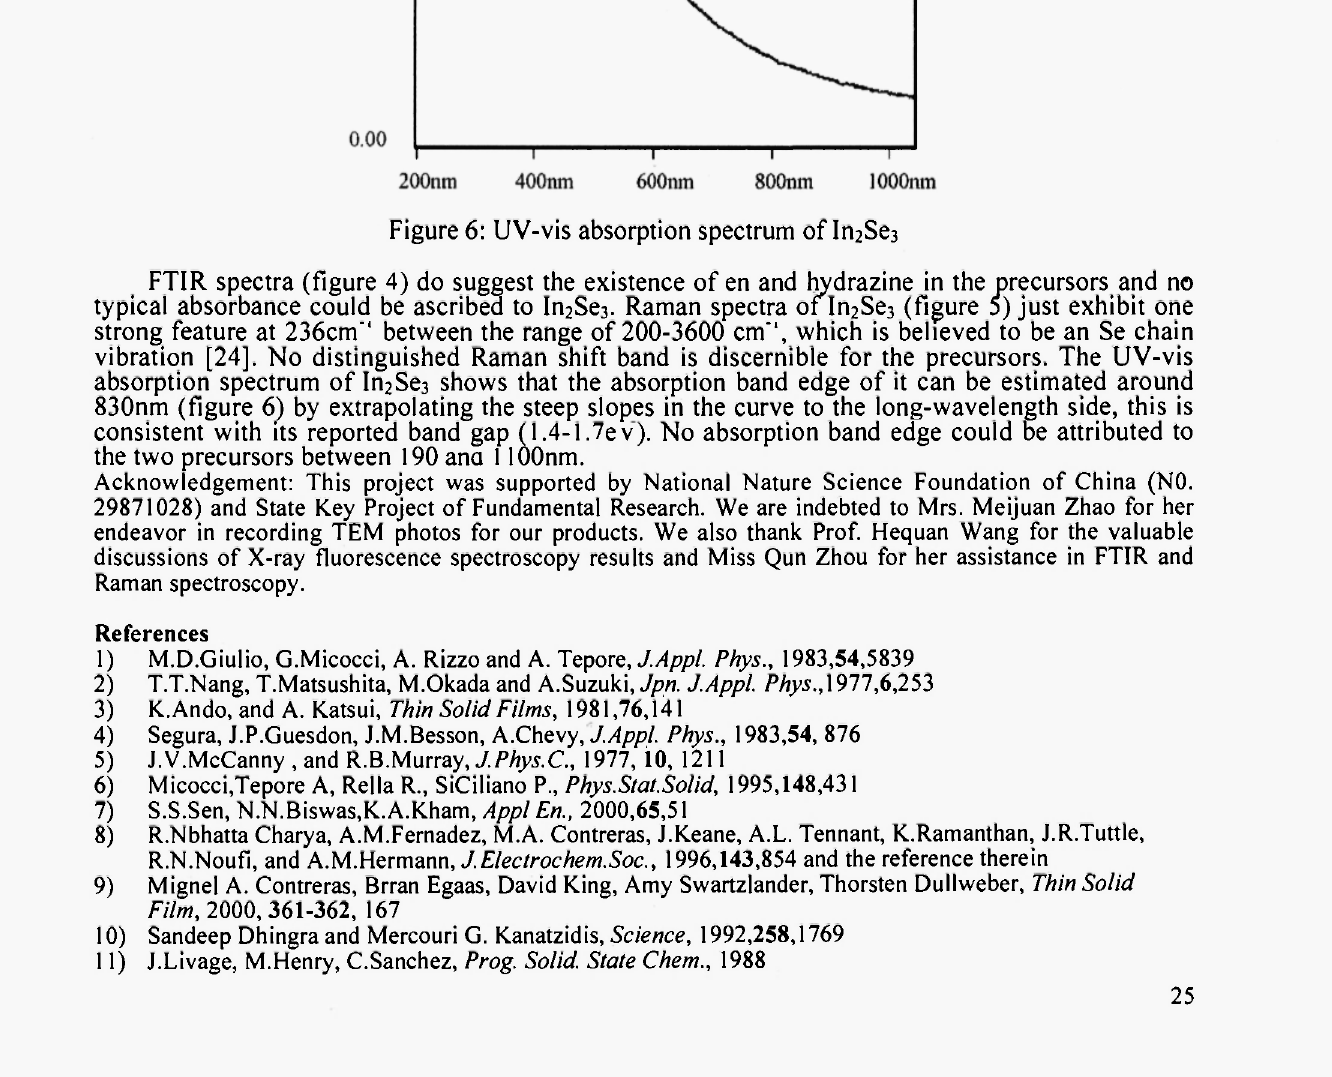
Figure 5: Raman spectrum of Iri2Se3